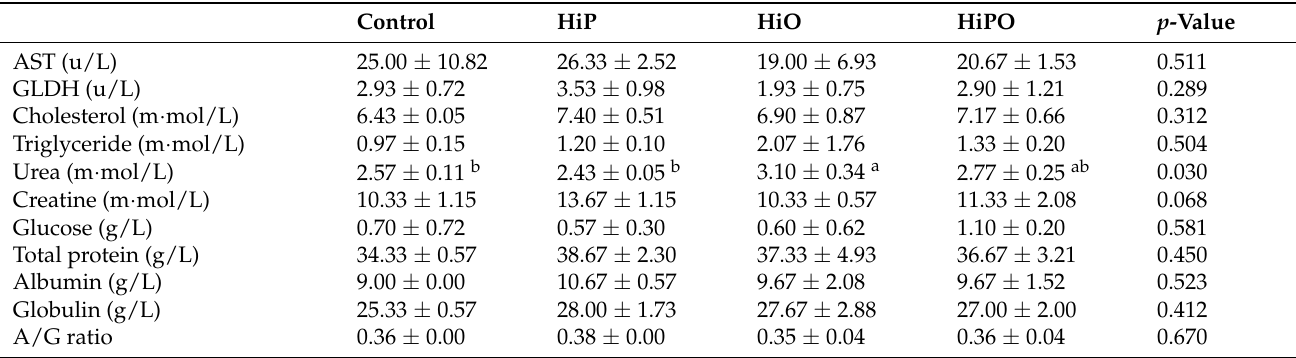
Table 5. Blood and serum biochemical parameters of barramundi fed partially defatted BSF larvae protein and oil as FM protein and oil replacement